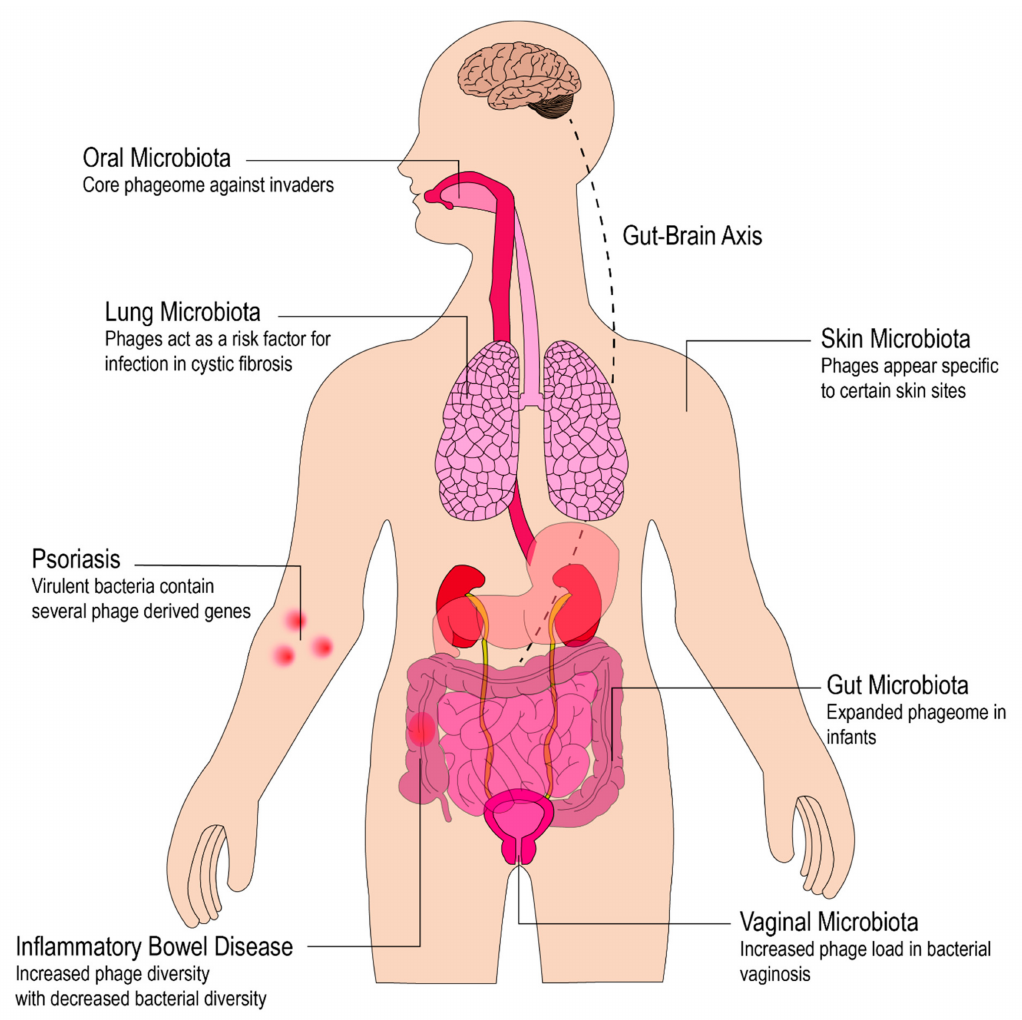
Figure 3. A diagram highlighting regions in the body in which phages have been indicated to play a role. These regions include the oral microbiota [54,55], the lung microbiota [56,57], the skin microbiota